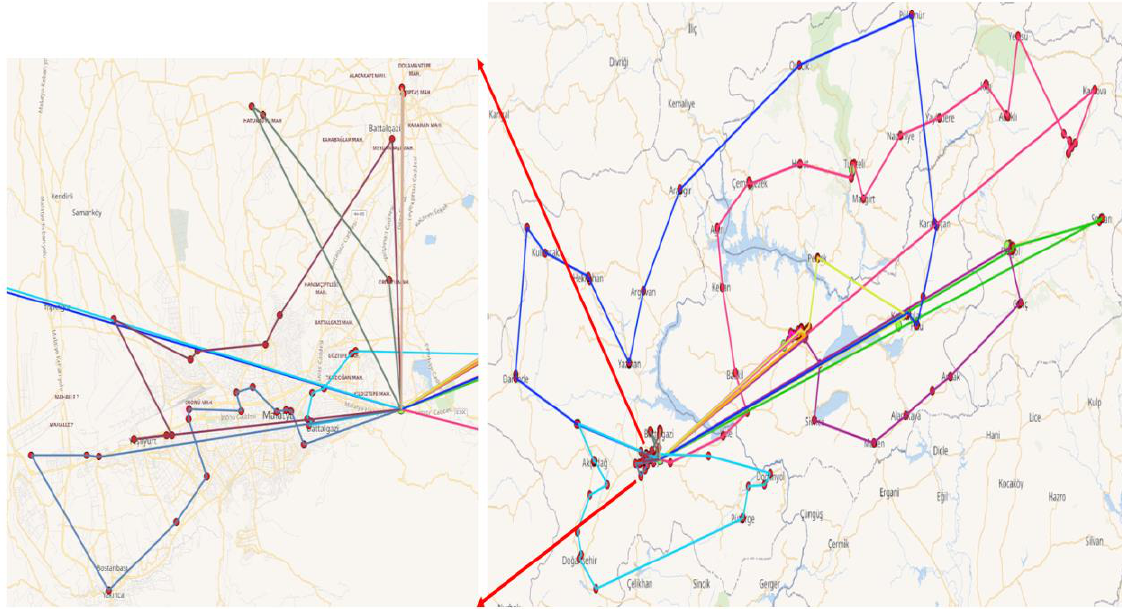
Figure 4. Disposal center located in Malatya province